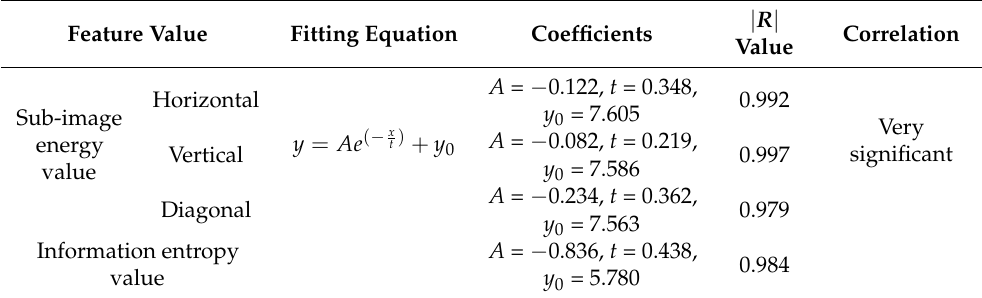
Table 2. Fitting equation and significance test of the relationship between image features before rust removal and corrosion depth.